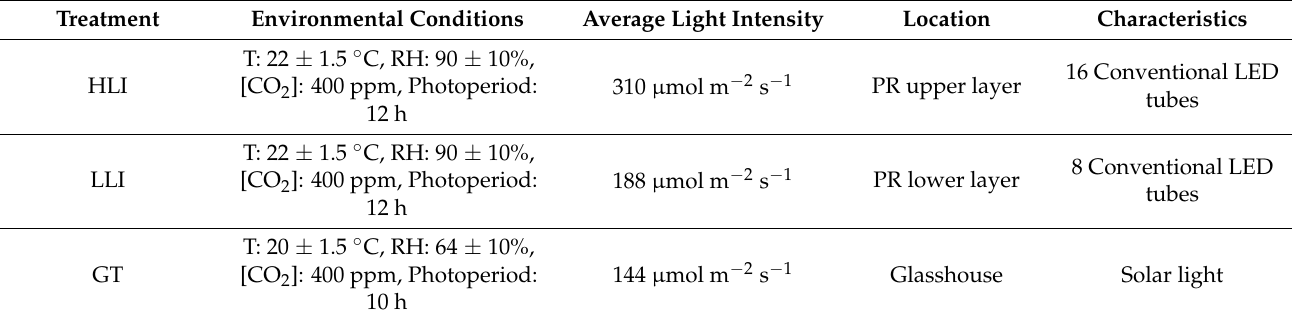
Table 1. Overview of the treatments’ characteristics and climate conditions studied. Treatment Environmental